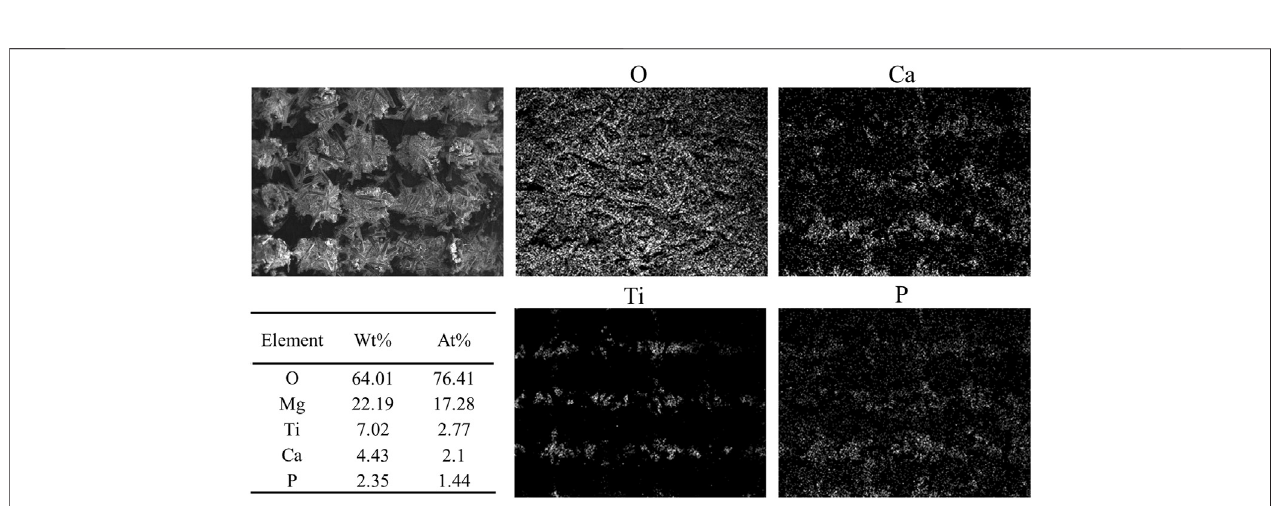
FIGURE 4 | SEM images and EDS analysis of the Mg-Ti composite after 7 days of degradation.